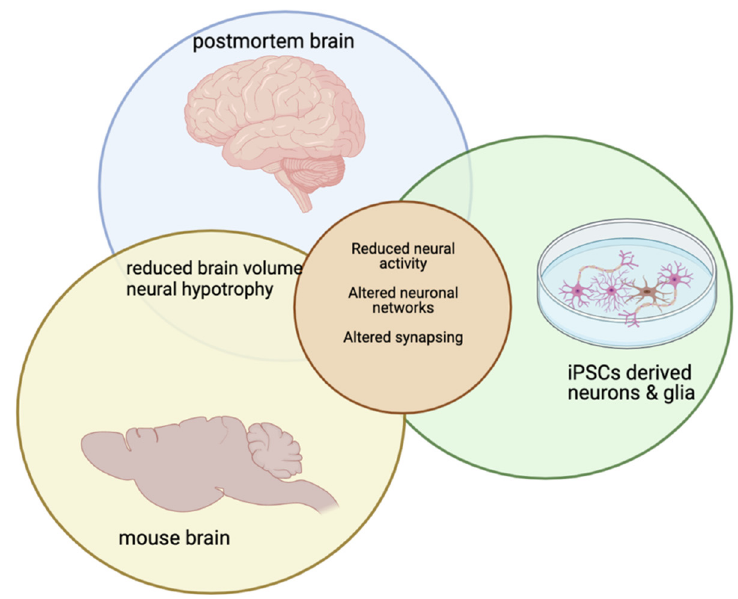
Figure 1. Cellular phenotype shared by mouse brain, post-mortem brain and iPSC-derived neurons and glia.